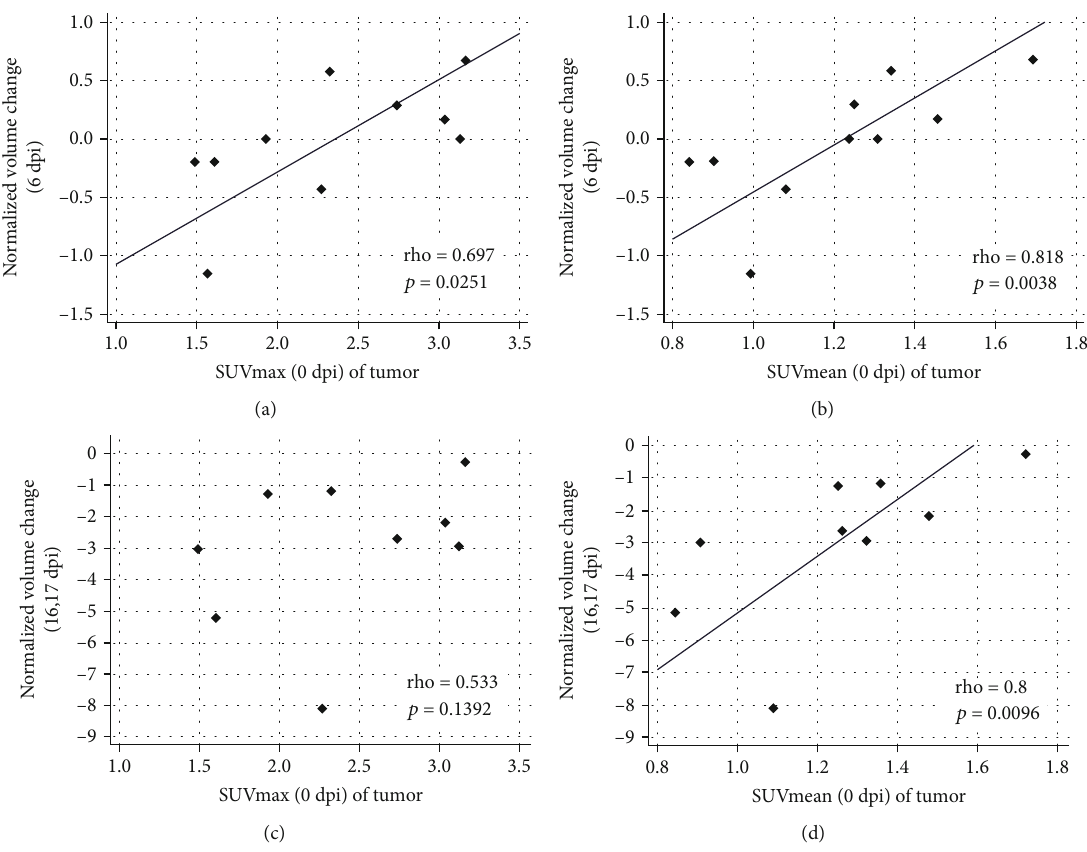
Figure 4: Correlations between treatment responses and pretreatment tumor FDG uptake in the CT26 colon cancer cell line mouse model. FDG uptake was measured as SUVmax and SUVmean. Data at 0 dpi were presented as mean data before BCT. Treatment responses were determined at two time points: early (6 dpi) and late (16 or 17 dpi). Normalized volume change is calculated using tumorvolume ð 0dpi Þ − tumorvolume ð × dpi Þ /tumorvolume ð 0dpi Þ . (a) Tumor SUVmax at 0 dpi and normalized volume change (6 dpi). (b) Tumor SUVmean at 0 dpi and normalized volume change (6 dpi). (c) SUVmax at 0 dpi and normalized volume change at 16 or 17 dpi. (d) SUVmean at 0 dpi and normalized volume change at 16 or 17 dpi. Footnote: Of the 11 mice, two died during studies; A5 at 2 dpi and A3 at 16 dpi (size measurements were performed until 12 dpi). Therefore, the number of mice for (a) and (b) was 10 and for (c) and (d), 9. Abbreviations: FDG, 2-deoxy-2[ 18 F] fl uoro-D-glucose; dpi, days post-injection; SUVmax, maximum standardized uptake value; SUVmean, mean standardized uptake